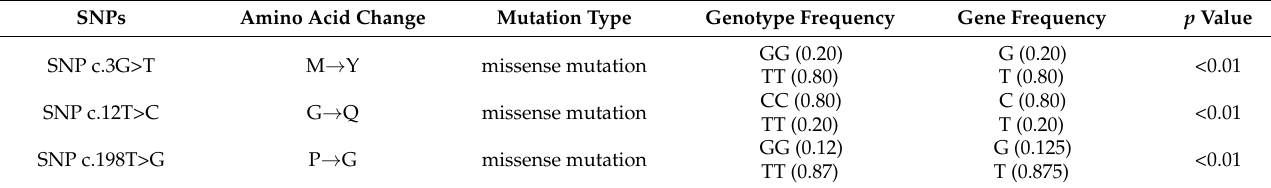
Figure 4. Distribution of the kiss1 gene in different tissues of male S. biddulphi. Different letters indicate that the difference is significant, and the same letters indicate that the difference is nonsignificant ( p > 0.05). Table 3. SNP locus information of the kiss1 gene.